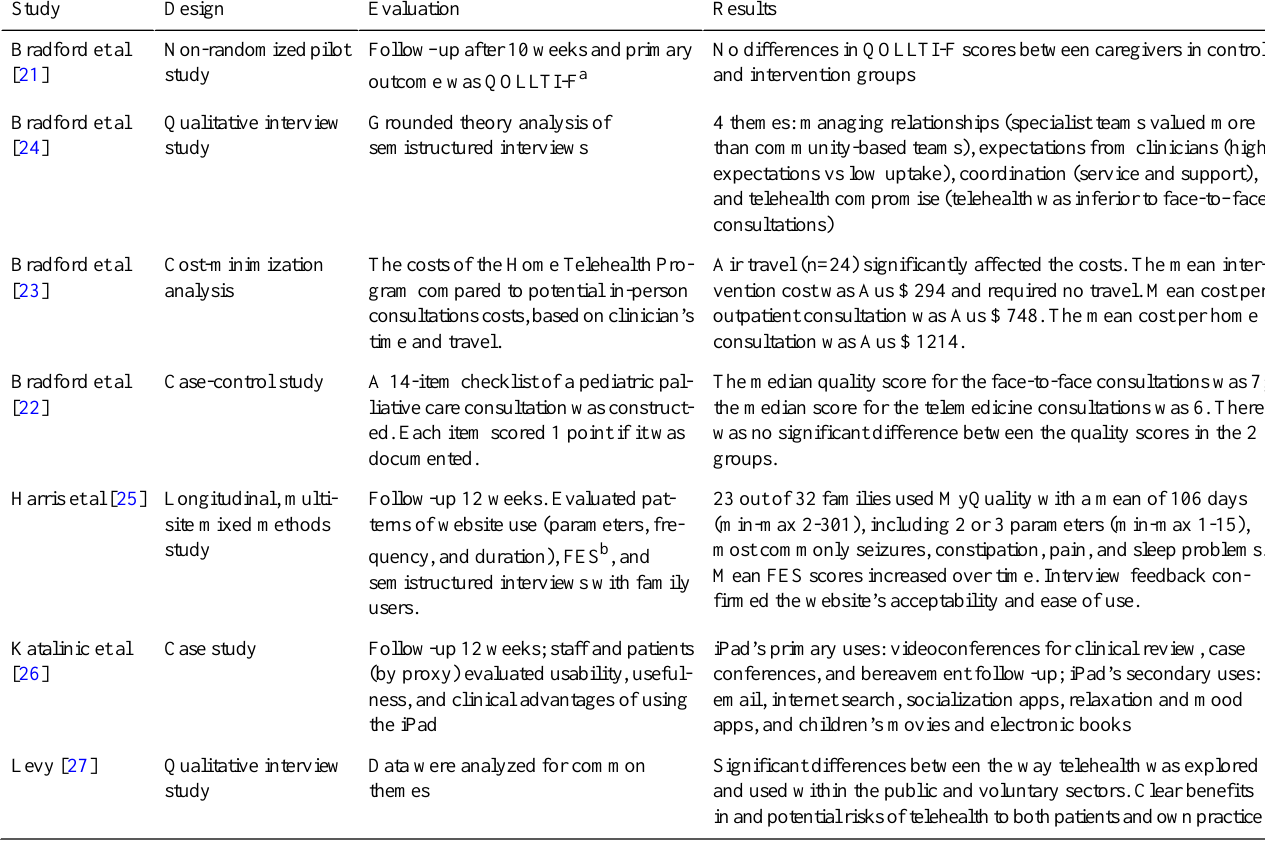
Table 3. Study design, evaluation, and results. ResultsEvaluationDesignStudy